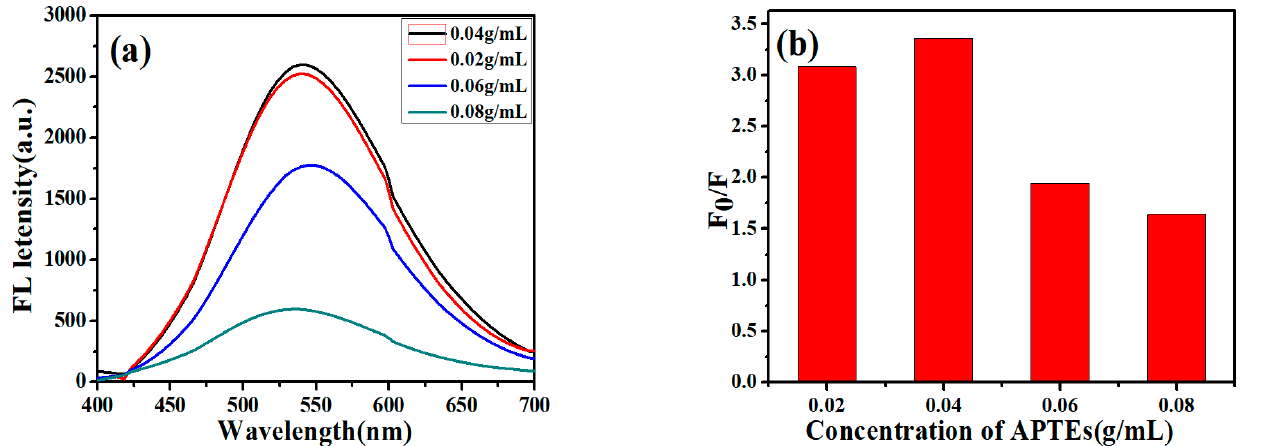
Figure 1. ( a ) Fluorescence emission spectra of ZCGQDs; ( b ) relative fluorescence intensity with the addition of 20 µM Cu 2+ to ZCGQDs.